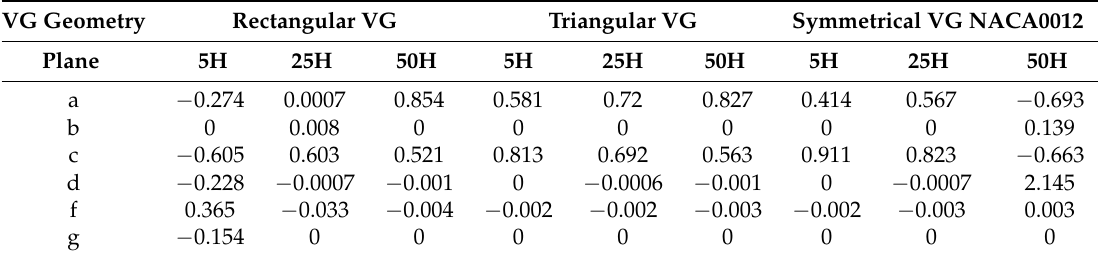
Table 4. Ellipse fitting coefficients for planes 5H, 25H and